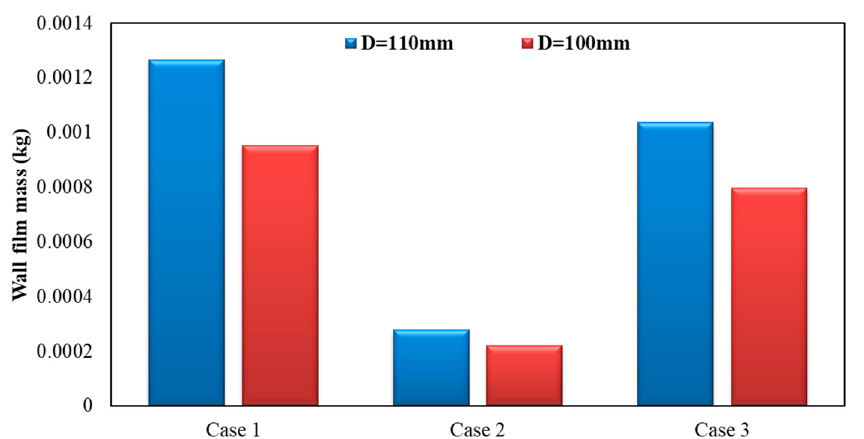
Figure 20. Influence of different exhaust pipe diameters on wall film